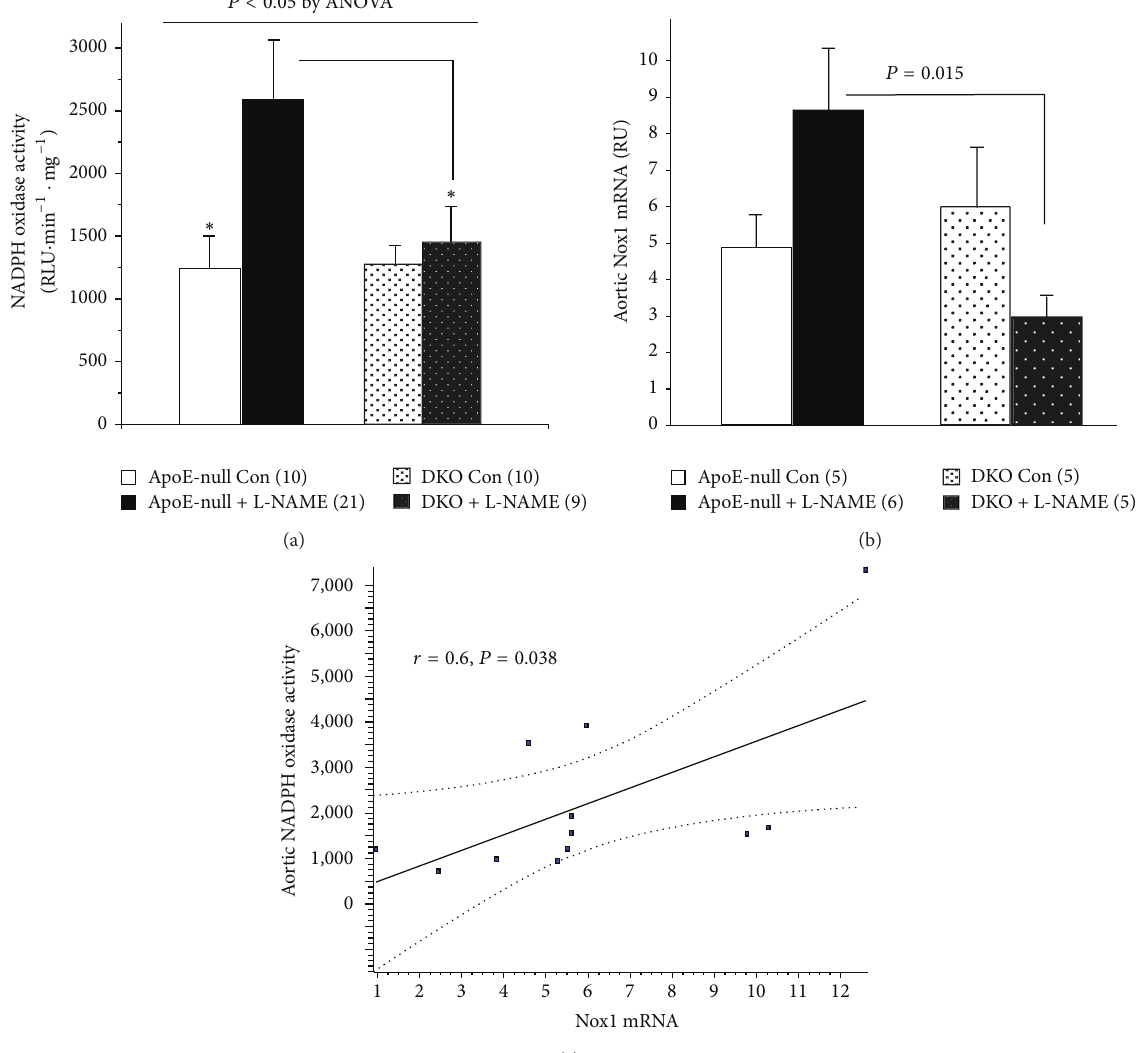
Figure 3: Aortic NADPH oxidase correlates with Nox1. (a) DKO mice are immune to the significant ( ∗ 𝑃 < 0.05 ) induction of NDAPH oxidase activity induced by L-NAME in the ApoE-null mice (mice number). (b) Relative expression of Nox1 mRNA (adjusted for actin) in mice aortas (mice numbers), which parallels NADPH oxidase activity, and is significantly correlated to it in a subset of mice in which both measurements were performed (c). Table 2: Aortic MCP1 and RAS components mRNA levels. Each group included 7–9 animals; while there were no differences between sexes, the breakdown by gender for each group is given in parentheses. Data are given as mean ± (SE). Data are expressed relative to the level in the ApoE-null control animals; thus, the Dunnett’s posttest was chosen to follow the ANOVA.